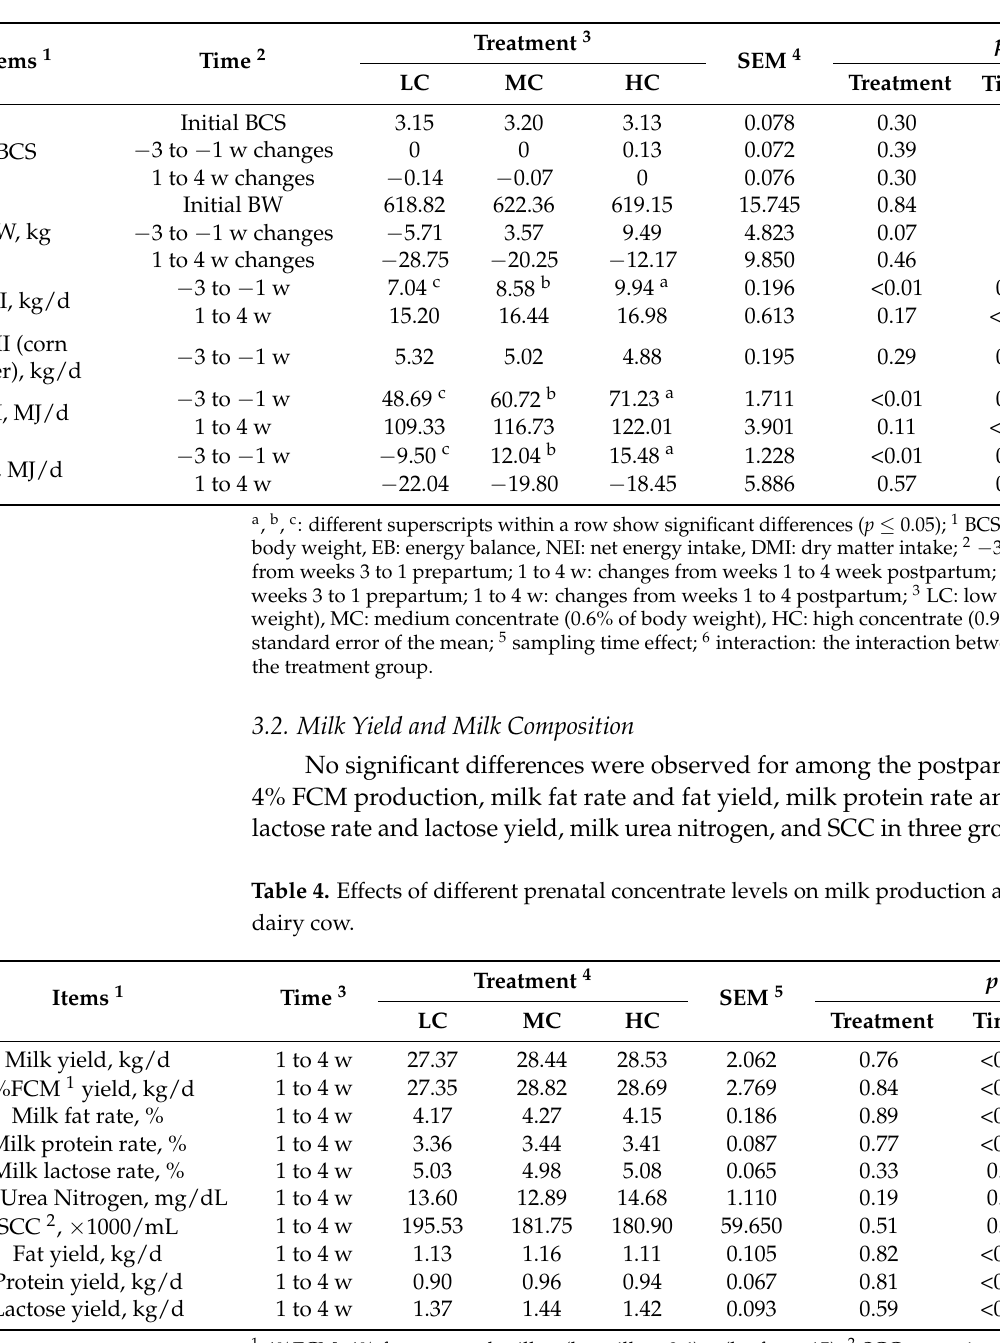
Table 3. Effects of different prenatal concentrate levels on the body weight and energy balance of dairy cows.